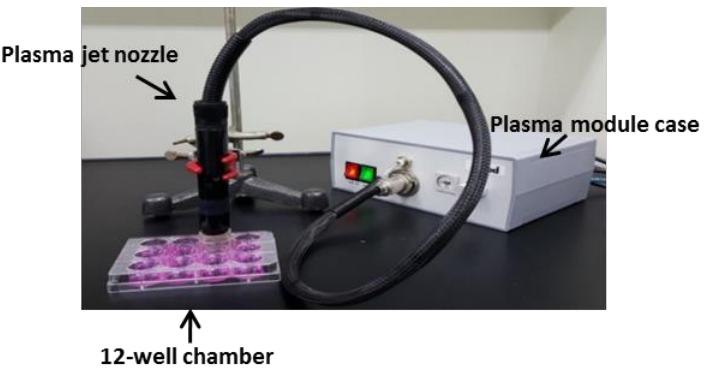
Figure 2. Generation of plasma-activated medium (PAM) using DMEM by jetting air plasma 2 cm above the surface of the medium in a well (2.5 × 2.2 cm) of a 12-well-plate.